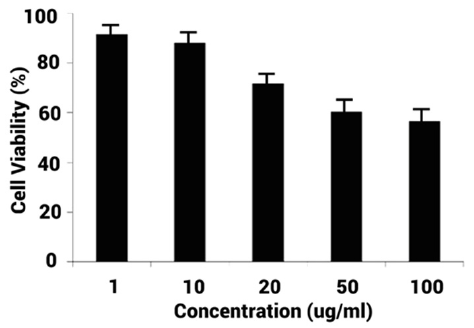
Figure 10. MTT assay graph showing the percentage of viable cells using different concentrations of AC-AgNPs.